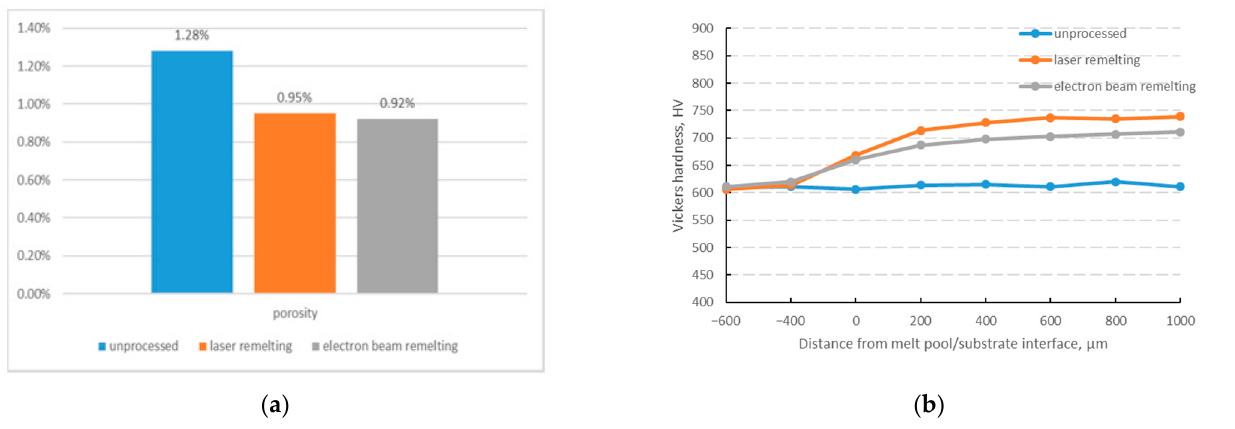
Figure 10. Mo-12Si-8.5B alloy with unprocessed, laser remelting and electron beam remelting. ( a ) porosity; ( b ) Vickers hardness.